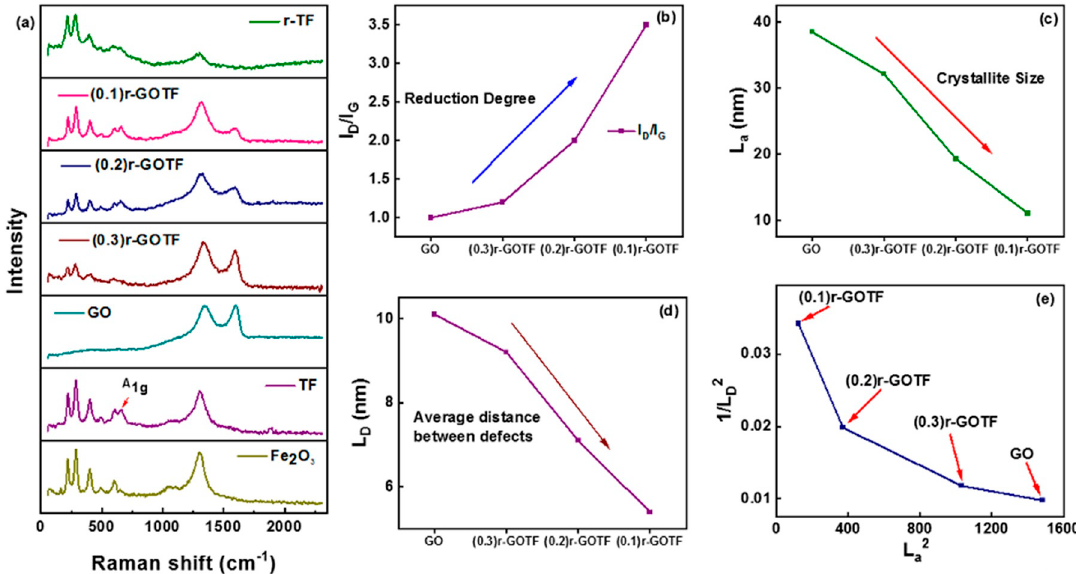
Figure 4. ( a ) Raman spectra of the synthesized composites, ( b ) I D /I G , ( c ) Variation of L a , ( d ) Variation of L D and ( e ) 1/L D2 vs. L a2 of nanocomposites. The crystallographic defects define the D-band, whereas the sp 2 hybridized carbon atoms in the carbon network define the G-band [38]. The intensity ratio (I D /I G ) is a quality measure of graphene derivatives based on the extent of flaws in their graphene-like struc- ture [65]. In other words, the degree of functional and disordered sites in graphene-based materials is represented by the I D /I G ratio. The variation of the I D /I G ratios of GO, (0.3)r- GOTF, (0.2)r-GOTF and (0.1)r-GOTF is shown in Figure 4 (b). The I D /I G ratio increases from 1.0 to 3.5 as reduction increases (GO ˂ (0.3)r-GOTF ˂ (0.2)r-GOTF ˂ (0.1)r-GOTF). Sug- gested here is that the creation of small-sized sp 2 carbon domains or an increase in the fraction of edges is a result of reduction by the ascorbic acid. Furthermore, as shown in Supplementary Figure S3, the D band of the nanocompo- sites has been blue-shifted away from the G band, further suggesting that reduction in- creased [63]. The rise in I D /I G values with the increasing range of reduction in the nano- composites strongly emphasizes that defects created in the reduced samples were due to the removal of oxygen groups. A reduction of full width at half maximum (FWHM) (Fig- ure S3) in all the composites upon increasing the degree of reduction was observed as tabulated in Table 2; it was due to the reduction in the defective graphene-like domains. This finding confirms that the number of defect sites present in the (0.3)r-GOTF, (0.2)r- GOTF and (0.1)r-GOTF composites and the extent of reduction can vary by changing the amount of GO loaded. The presence of amorphous carbon and crystalline ( graphene-like ) materials is very important in photocatalytic applications. This is due to the simultaneous adsorption and photocatalytic performance. This phenomenon is further explained in Sec- tion 3.7.